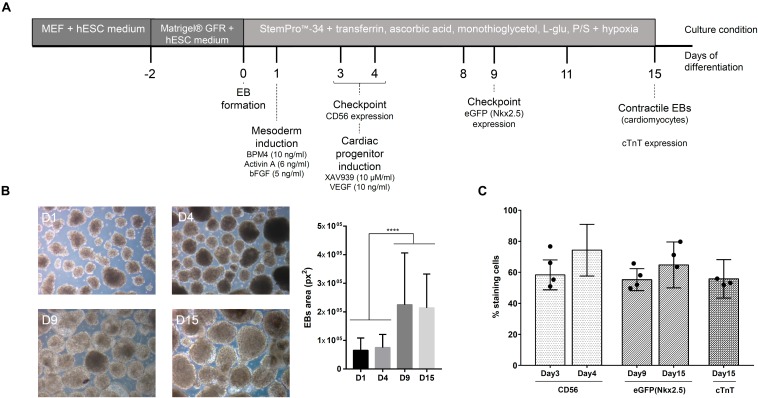
Cardiomyogenic differentiation of hESCs. (A) Timeline of the cardiac differentiation protocol. (B) Representative images of embryoid bodies (EBs) during differentiation and the measurement of their size (manual measurement at ImageJ software) (n = 10 images). ****p-value < 0.0001; statistical analysis was performed using one-way ANOVA and Tukey’s posttest. (C) Percentage (mean ± SD) of cells positive for different markers during cardiac differentiation (CD56 – mesoderm; eGFP/Nkx2.5 – cardiac progenitor; cTnT – cardiomyocytes) (n = 6); the black dots represent the percentage of respective markers in cell population selected for experiments used for MS analysis.